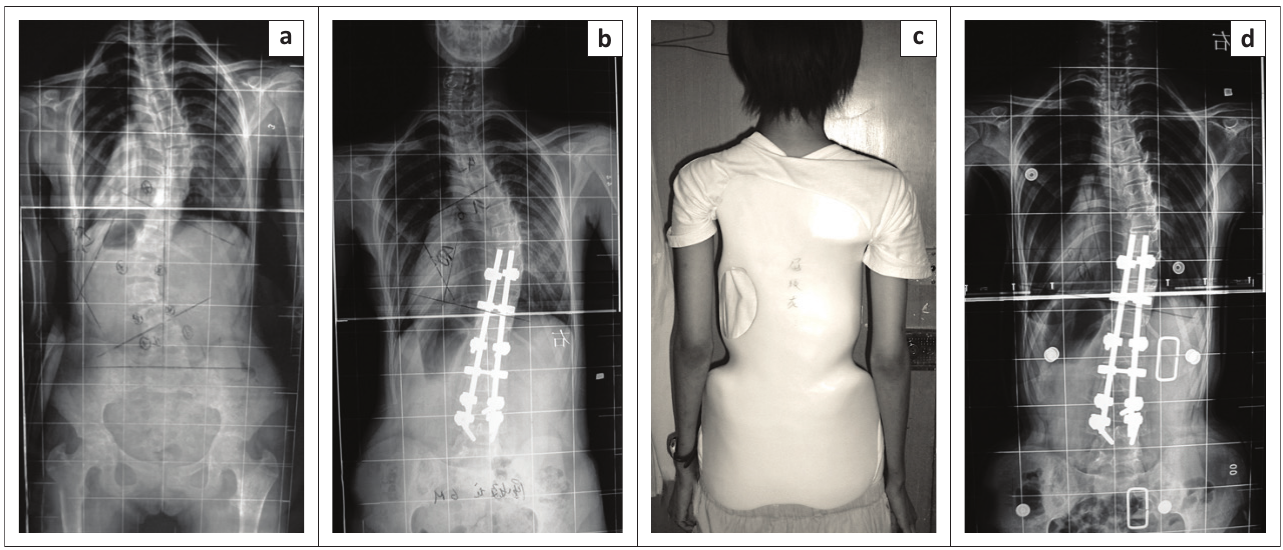
FIGURE 5: (a) X-ray of a patient with a Lenke 3C pattern before undergoing surgery. (b) Only the lumbar part was fused, and because of the decompensation of the thoracic curve, a brace (c) was made with moderate correction of the thoracic curve (d). With appropriate planning of this surgery, these issues would have been